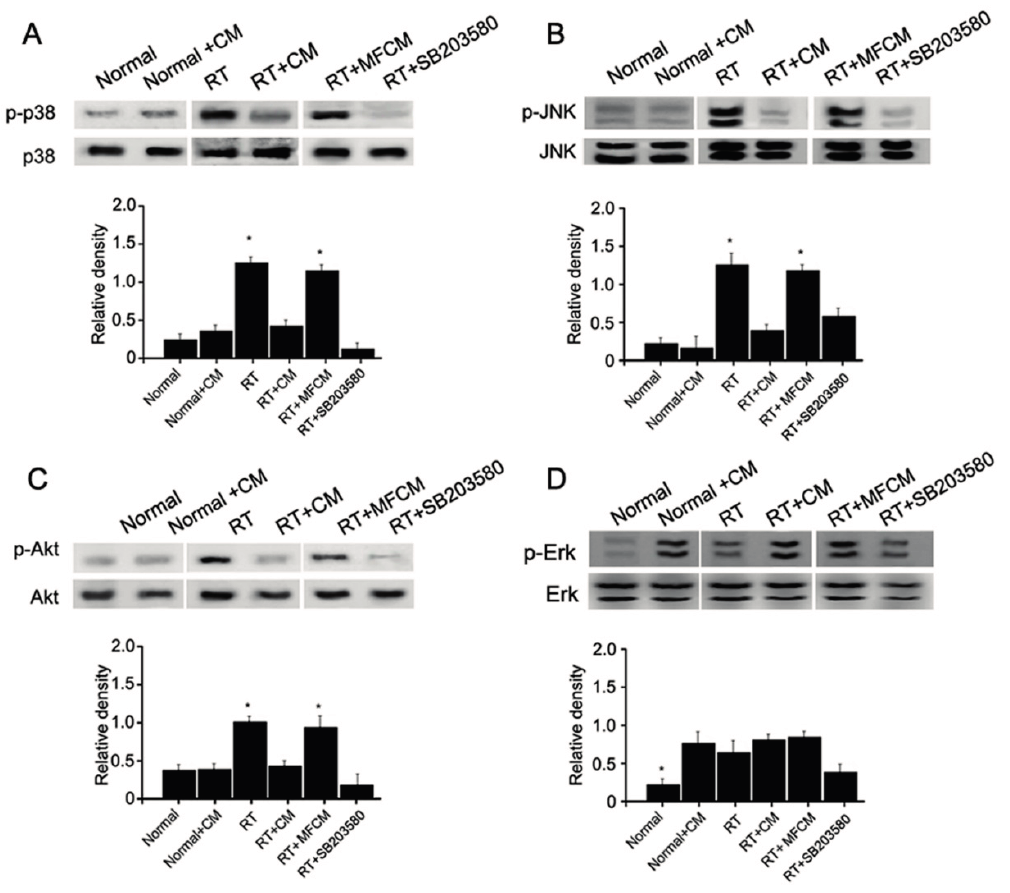
Figure 6. iPSC-CM suppresses the p38/JNK pathway. ( A ) Western blot ( upper ) and quanti fi cation ( lower ) of p38, JNK ( B ), Akt ( C ) and Erk ( D ) phosphorylation from the irradiation injury lacrimal gland showing the effects of administering MFCM, p38 inhibitor (SB203580, a p38 MAPK inhibitor with IC50 of 0.3–0.5 μ M.) or iPSC-CM on p38 phosphorylation in irradiation injury lacrimal glands. Lacrimal injury was induced in mice receiving radiotherapy. Data shown are the mean ± SD of five independent experiments. In ( A ), ( B ) and ( C ) * p <0.05 vs. normal, normal + CM, RT + CM, or RT + SB203580; In ( D ) * p < 0.05 vs. normal + CM, RT, RT + CM, RT + MFCM, or RT + SB203580 (normal + CM: non-irradiated after iPSC-CM treatment, RT: radiotherapy, RT + CM: radiotherapy after iPSC-CM treatment, RT + MFCM: radiotherapy after mouse fibroblasts conditioned medium treatment); N =